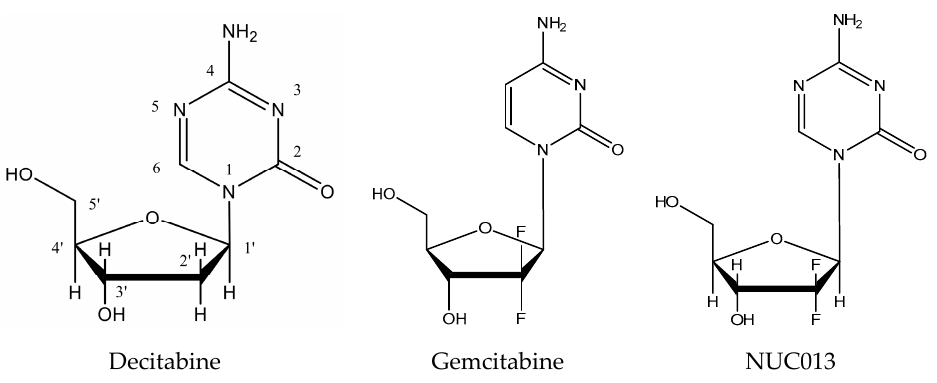
Figure 1. Comparison of the structures of decitabine, gemcitabine and NUC013.